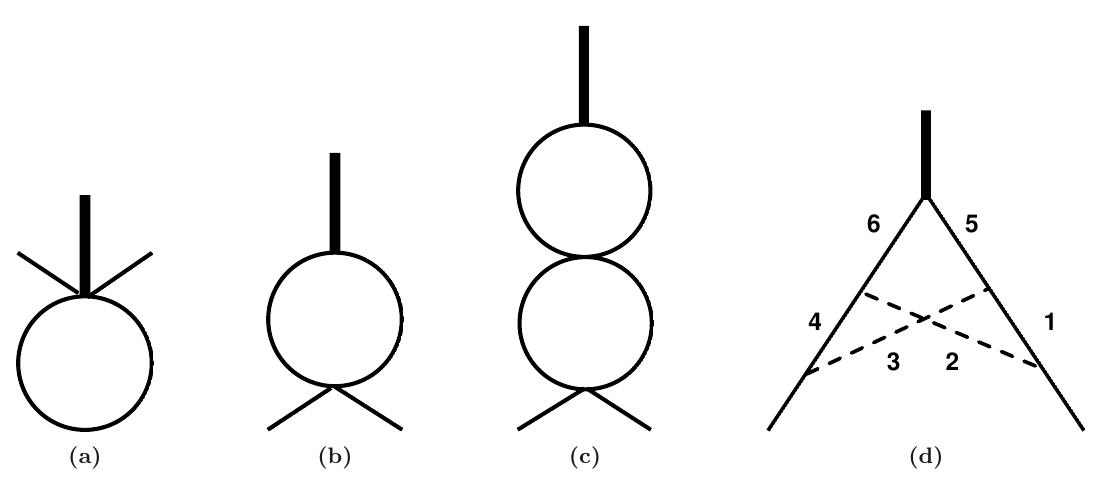
Figure 3. The two one-loop master integrals are shown in (a) and (b). One of the 17 master two-loop integrals is shown in (c) and the remaining 16 master integrals are obtained from (d) as described in the text. Solid and dashed internal lines correspond to massive and massless scalar propagators. Thin external lines are on the mass shell and thick external lines carry the (off-shell) momentum q